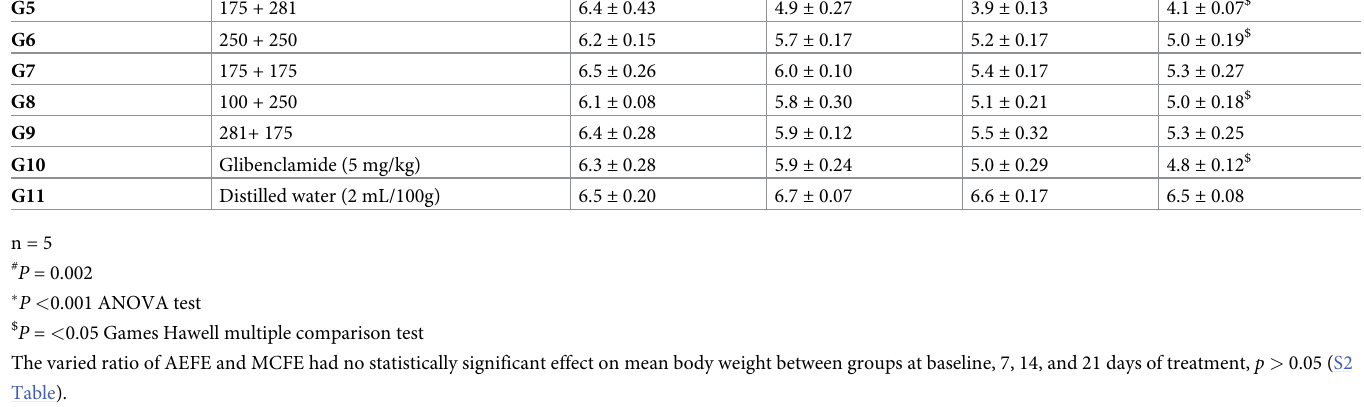
Table 4. Effect of varied dose ratio on fasting plasma glucose levels in rats. Groups